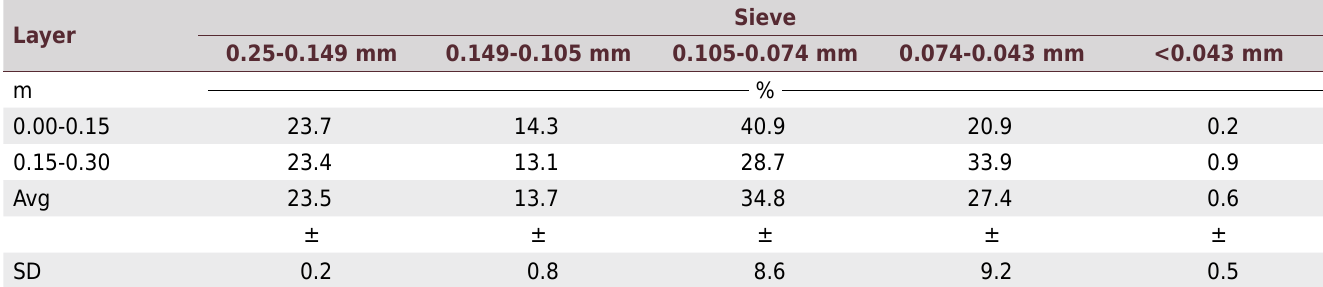
Table 4. Distribution of aggregates ≤0.25 mm of soil samples from the Comarca Lagunera, Mexico Layer